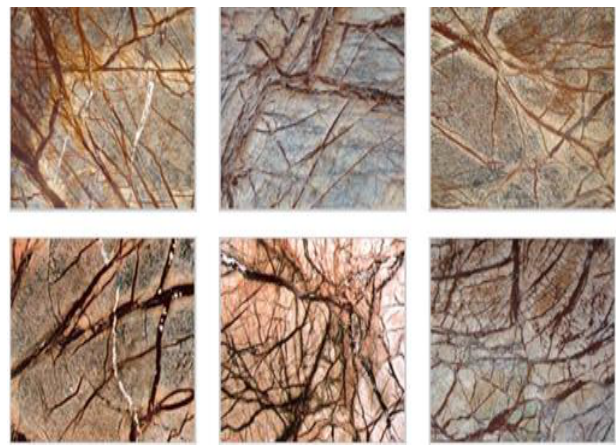
Figure 1. Polished rock slab examples from Bidasar showing bifurcating hydraulic injection veins. Image dimensions about 1 square meter (courtesy Dewan Group).